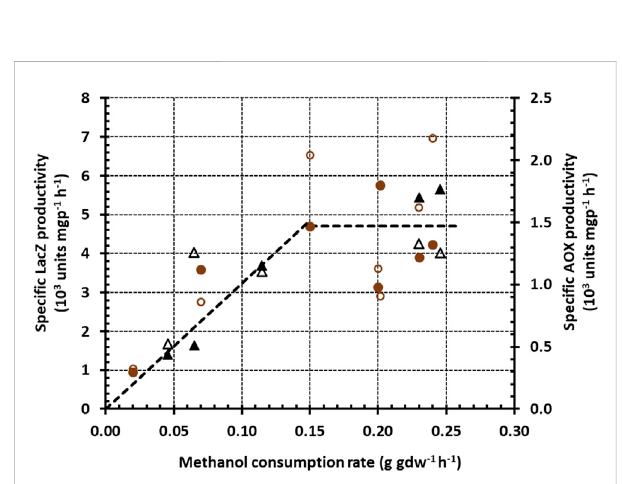
FIGURE 4 Variation of the speci fi c LacZ (closed symbols) and AOX (open symbols) productivities with the speci fi c methanol consumption rate duringgrowthonmethanol +glycerol(browncircles)andmethanol+ sorbitol (black triangles). The graph was obtained by plotting the speci fi c methanol consumption rates in Figures 2B, 3B against the corresponding speci fi c LacZ and AOXproductivities in Figures 2D,